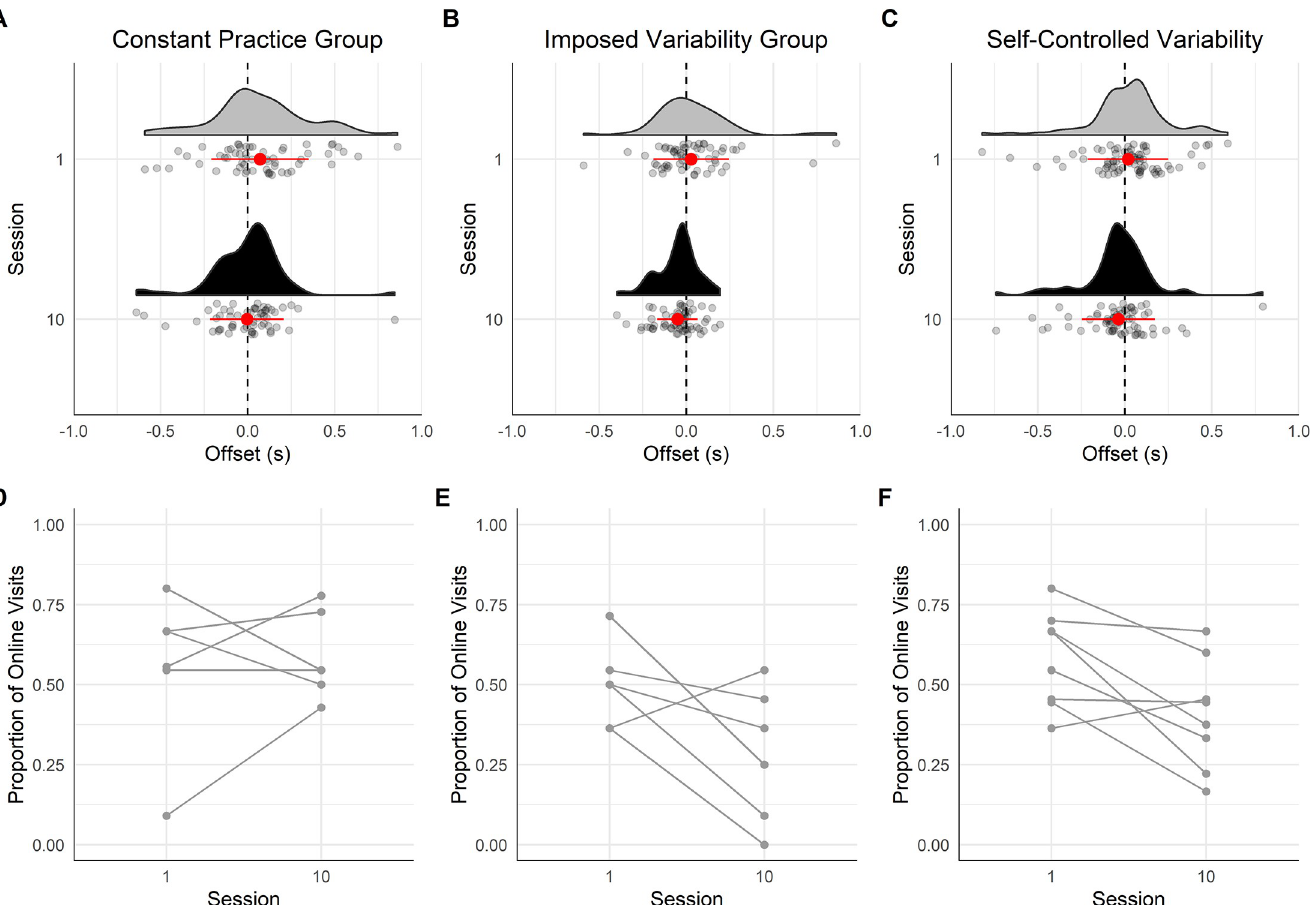
Fig 8. Offset time of the last gaze visit before the hand contacted the handhold for the three groups on the transfer route. In (A), (B) and (C), the vertical dashed line shows the time the hand touched the handhold, each point represents one gaze visit, the half violin shows the density of points, the red/grey point with the error bar refers to the mean of all the gaze visits and the standard deviation around the mean. The color of the half violin refers to the learning session: in grey, session 1 and in black, session 10. (D), (E) and (F) displays the individuals’ proportion of online visits on session 1 and 10. (A) and (D) show data for the constant practice group, (B) and (E) for the imposed variability group, and (C) and (F) for the self-controlled variability